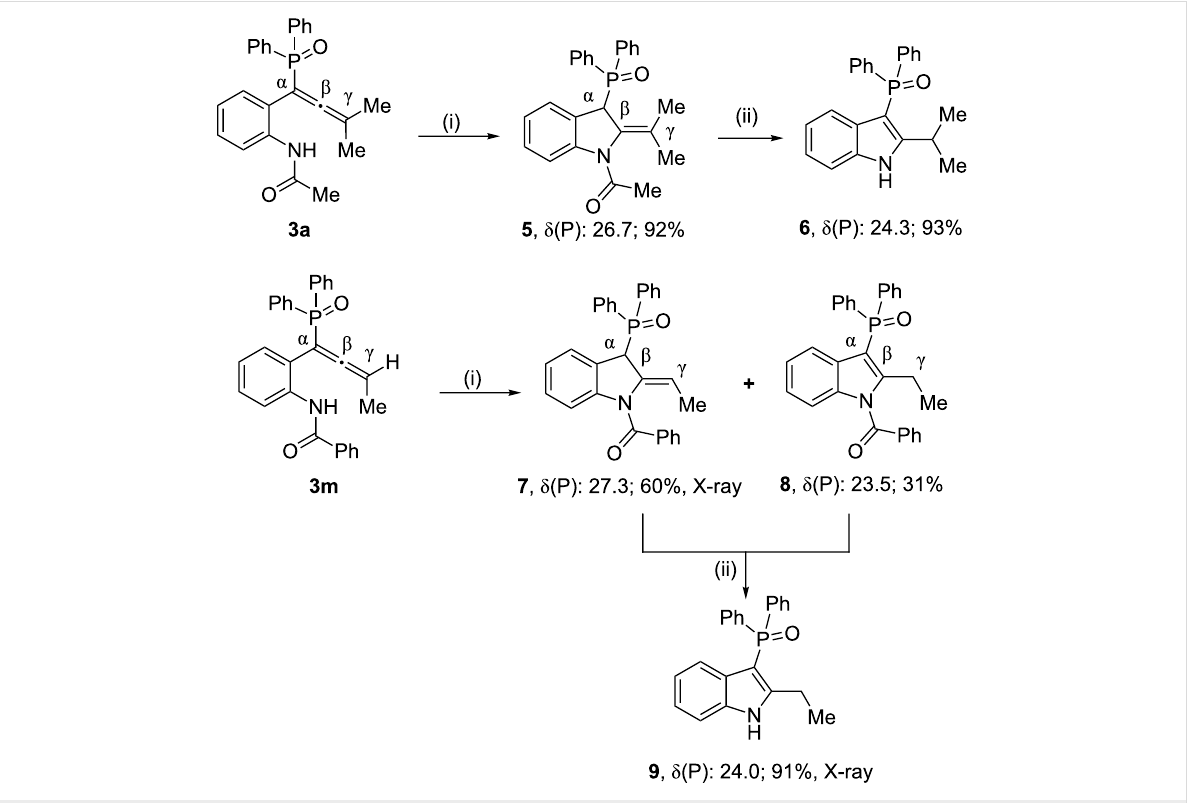
Scheme 3: Reaction of functionalized allenes 3a and 3m leading to phosphinoylindoles. Conditions: (i) K 3 PO 4 (0.5 equiv), THF, 80 °C, 12 h, (ii) NaOH (2 equiv), EtOH/H 2 O (4:1), 80 °C, 8 h.